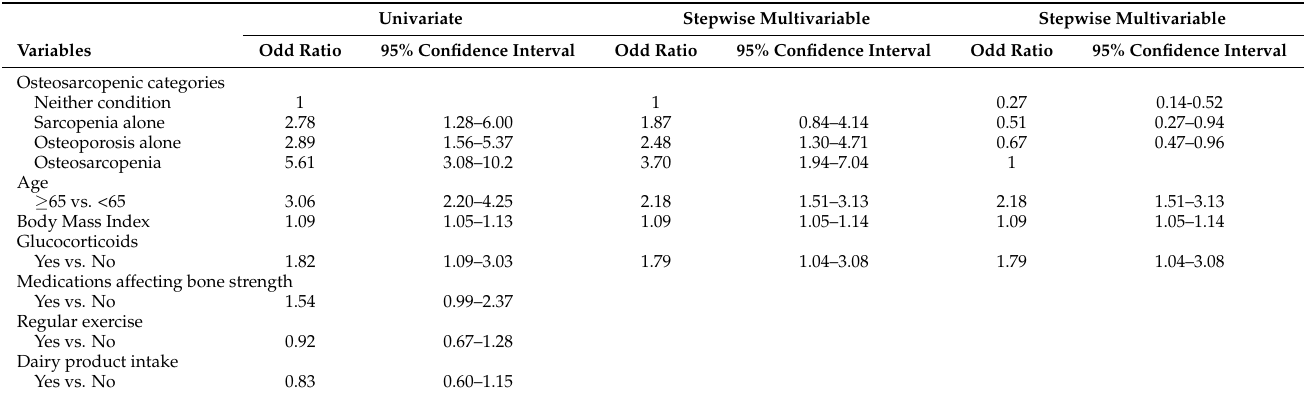
Table 4. Odds ratios for fragility fractures according to osteosarcopenic categories, in which the “osteo” component included high risk osteopenia ( − 2.5 SD < T-score < − 1 SD) and osteoporosis (T-score ≤ − 2.5 SD), using two different referents. Univariate